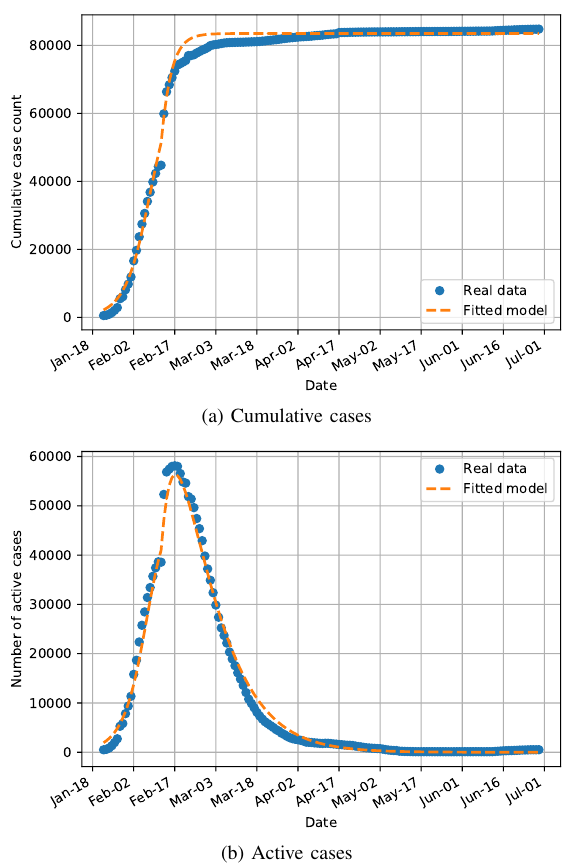
Fig. 2: Actual data and fitted solution from 22 January to 29 June 2020. Dots are the real data and dotted lines are obtained from simulations. (a) cumulative number of reported cases; (b) active reported cases.